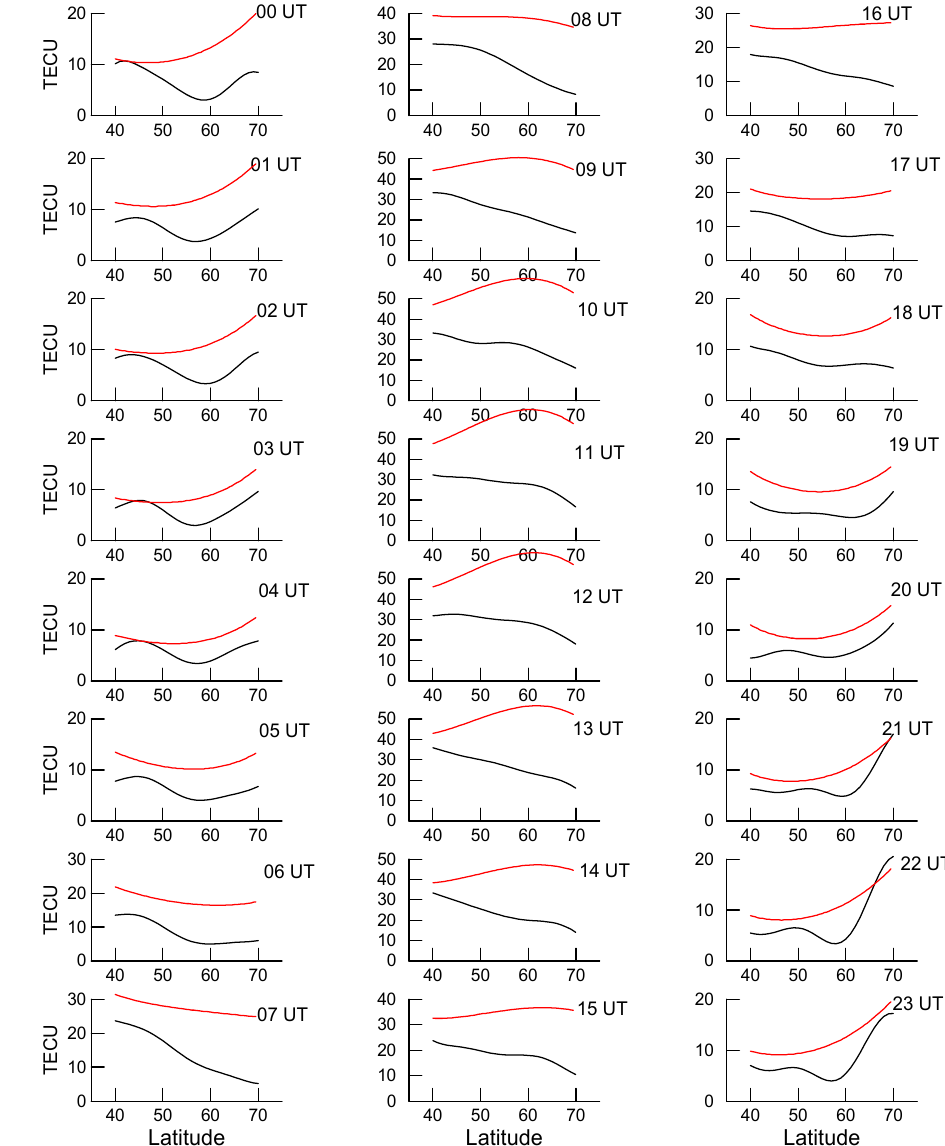
Fig. 8. Comparison between latitudinal profiles of GPS-derived TEC (black) and IRI model (red) for December 1999.